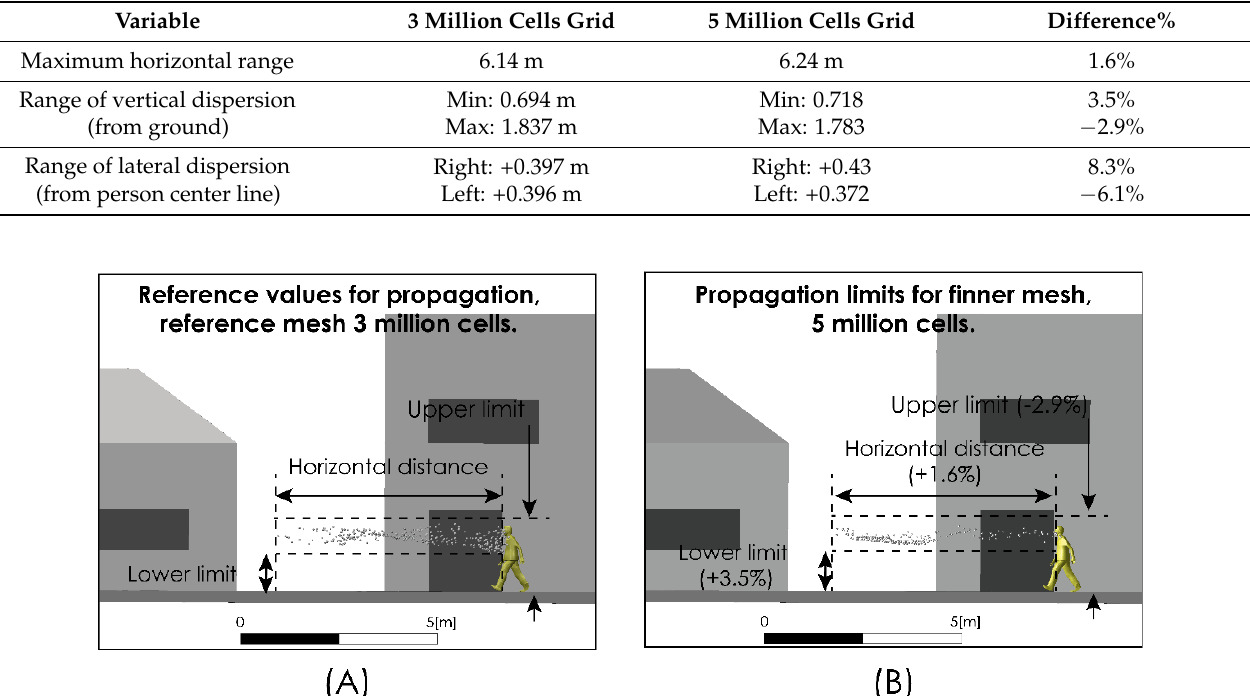
Figure 4. Grid convergence analysis. Droplet aerodynamic dispersion: 3 million cells grid ( A ) and 6 million cells grid ( B ).